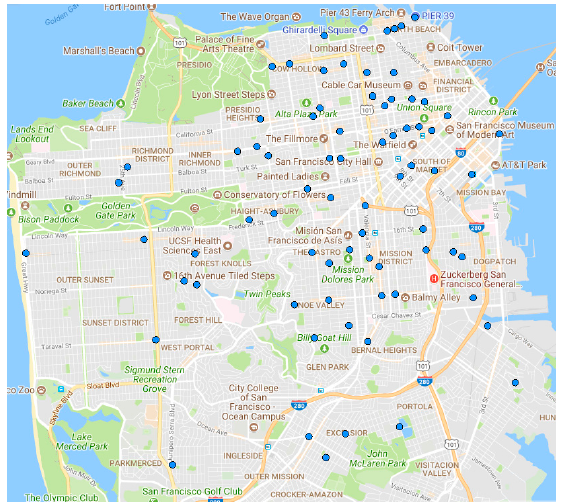
Figure 9. The most densely distributed area of detected stay places. The results are detected based on DS1